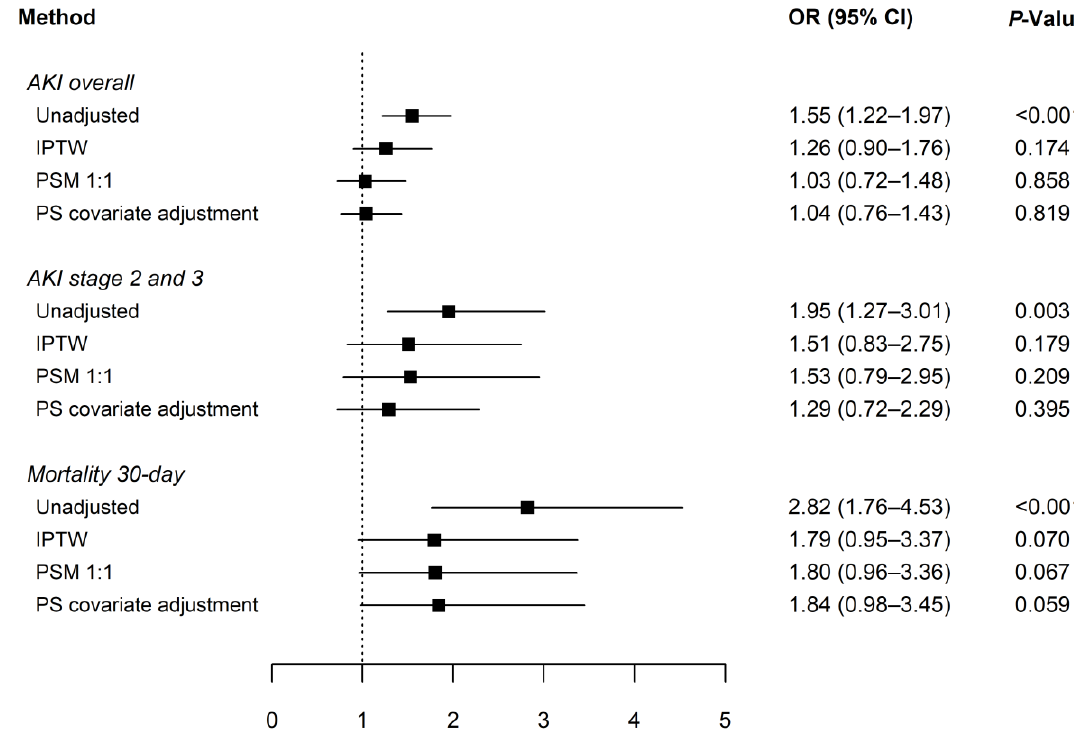
Figure 5. Forest plot showing the association of intraoperative 20% albumin administration with the occurrence of AKI and 30-day mortality. Solid squares represent the odds ratio (OR), and the horizontal line represents the 95% confidence interval (CI). AKI, acute kidney injury; IPTW, inverse probability of treatment weighting; PSM, propensity score matching; PS, propensity score.